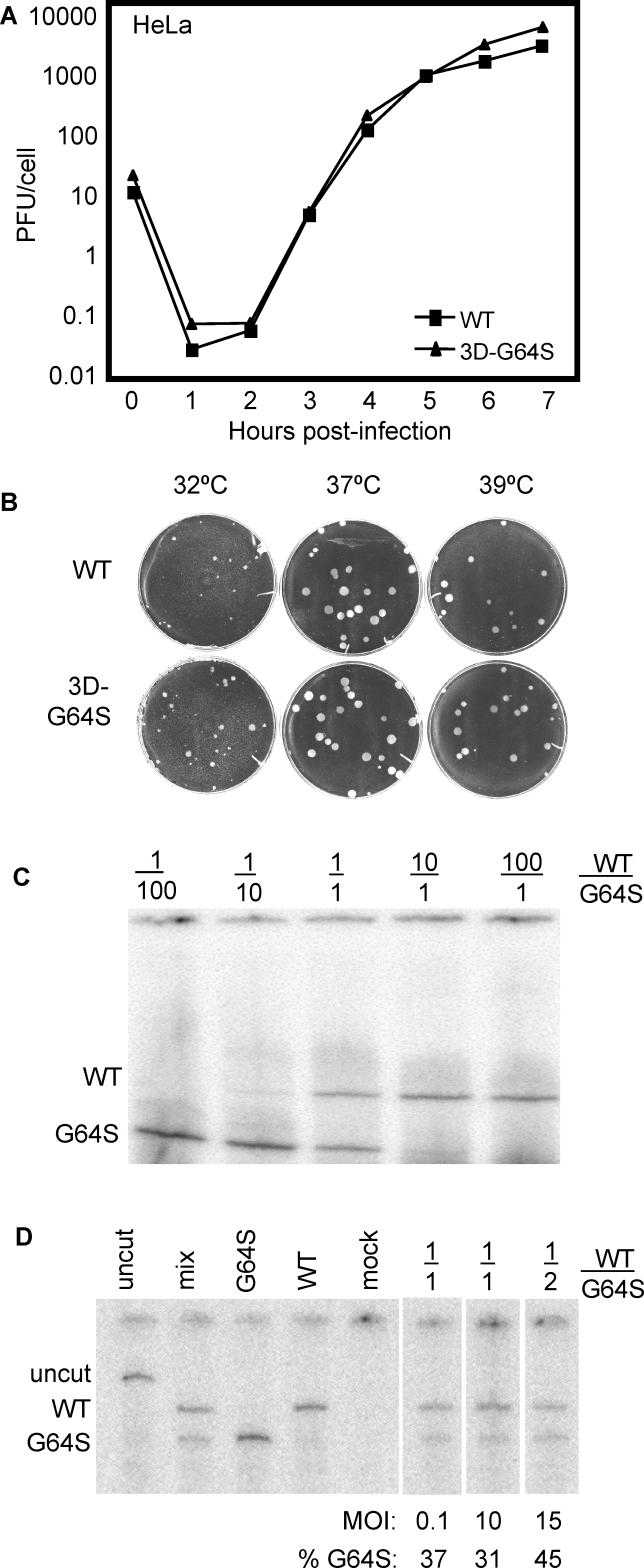
Growth of Wild-Type and 3D-G64S Poliovirus in HeLa Cells(A) Single-cycle growth curve. 2 × 106 HeLa cells were infected at an MOI of 10 PFU/cell with either wild-type or 3D-G64S viruses at 37 °C. Cell-associated virus was harvested at indicated times and titered by plaque assay.(B) Plaque assays. Wild-type or 3D-G64S poliovirus was plated on HeLa cell monolayers and incubated under an agar overlay for 48 h at indicated temperatures before staining the cells with crystal violet.(C) Competition assay titration with plasmid DNA. Plasmid DNAs that encode wild-type and 3D-G64S poliovirus were diluted and mixed at the ratios indicated: for example, 1/100 denotes a ratio of 0.1 ng of wild-type viral cDNA to 10 ng of 3D-G64S cDNA. End-labeled PCR products were digested with BstBI and were electrophoresed on denaturing polyacrylamide gels.(D) Competition assay in HeLa cells infected with wild-type and 3D-G64S virus. HeLa cells (2 × 106) were infected at an MOI of 0.1 or 10 PFU/cell, as indicated, with wild-type virus, 3D-G64S virus, or both, and cells were harvested 5 h after infection. RNA was extracted, subjected to RT-PCR as in (C), and digested with BstBI. Control bands “uncut” and “mix” were amplified from cDNAs. Products from MOI 0.1 single infections with wild-type, 3D-G64S- and mock-infected cells are shown, as are mixed infections with a 1/1 ratio of wild-type and 3D-G64S virus (MOI of 0.1 PFU/cell or 10 PFU/cell for each virus) and a 1/2 ratio (MOI of 5 and 10 PFU/cell, respectively). Products were quantified by Phosphorimager and the percentage 3D-G64S is shown.DOI: 10.1371/journal.ppat.0010011.g003